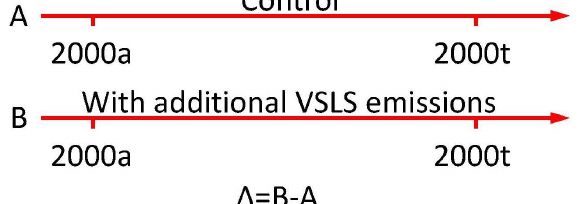
Figure 2: Summary of the two pairs of experiments. Pair A compares integrations with and without halogen activation on PSCs. Pair B compares integrations with and without additional halogenated species emissions. The differences (Δ) are defined in a way that the run with generally higher ozone is subtracted from the run with lower ozone. See Figure 3 for total ozone changes. Note that the runs are timeslice integrations, and consecutive model years are for the same year 2000 boundary conditions. However the individual years in each run differ due to internal variability as indicated by the letters behind all ‘2000’ time-line labels.